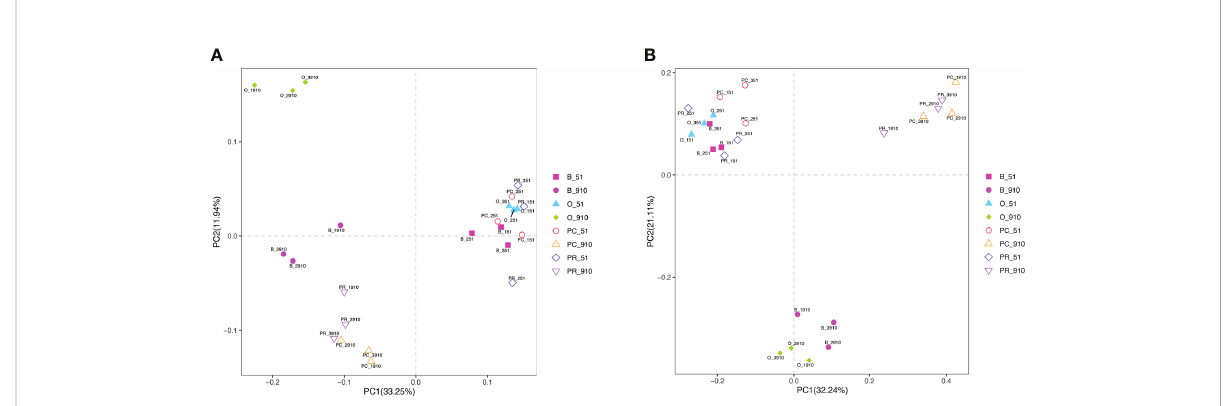
FIGURE 2 Principal coordinate analysis (PCoA) of soil bacterial (A) and fungal (B) communities. B_51, O_51, PC_51 and PR_51 indicate the samples from B, O, PC and PR treatments at pre-planting, respectively; B_910, O_910, PC_910 and PR_910 indicate the samples from B, O, PC and PR treatments at